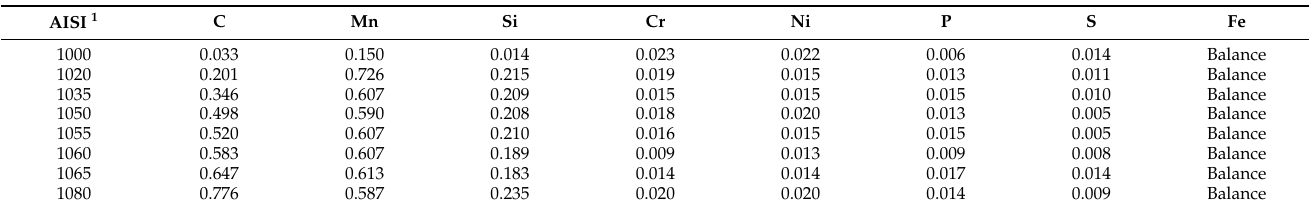
Table 1. Chemical composition of the AISI 1000 series plain carbon steels (wt.